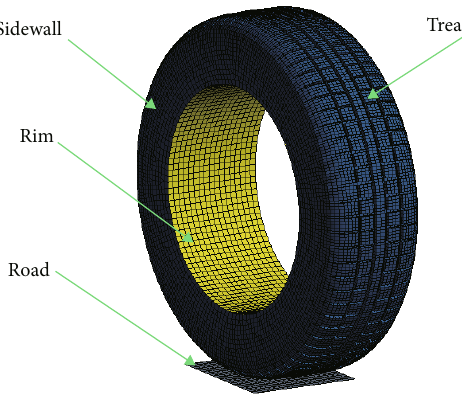
Figure 1: Finite element model of tire and